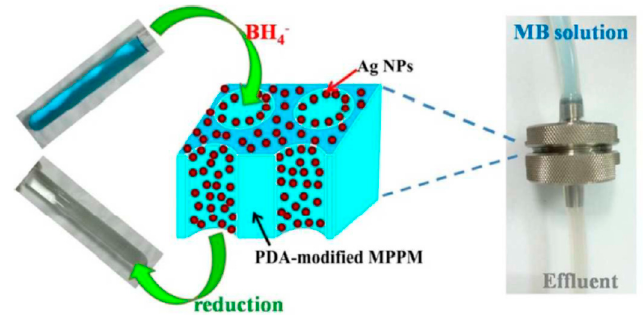
Figure 10. Reduction of MB with the AgNPs-immobilized MPPM in a flow-through membrane reactor. ((Reproduced by permission of the Royal Society of Chemistry from [51]–Reproduced by permission of The Royal Society of Chemistry).